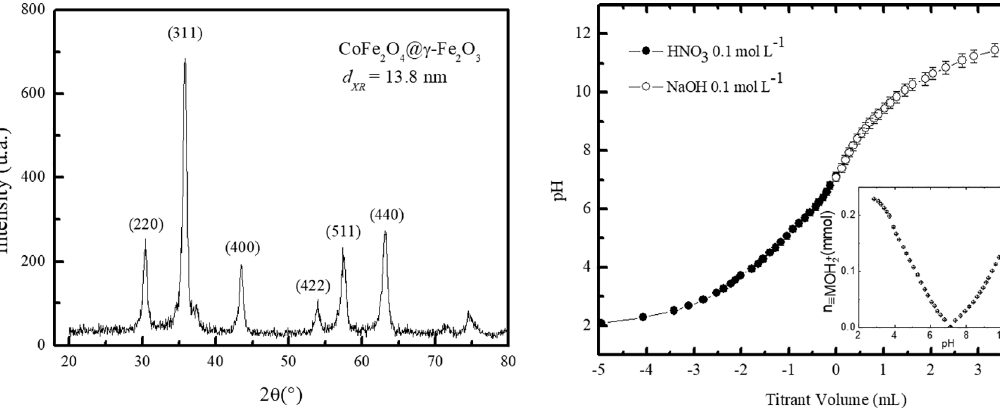
Figure 1. XRD pattern for sample A where the characteristic (hkl) Figure 2. Typical curves of potentiometric titrations starting from interplanar planes of the spinel structure are labeled. the PZC (sample A). Negative values of titrant volume refer to the titration of the acid range while positive values are related to the titration of the alkaline range. The inset shows the number of moles of ) and results of the Table 1. Value of nanoparticles mean sizes ( d XR surface protonated (left) and deprotonated (right) in function of pH. saturation value of the surface charge density ( σ 0sat ) obtained with